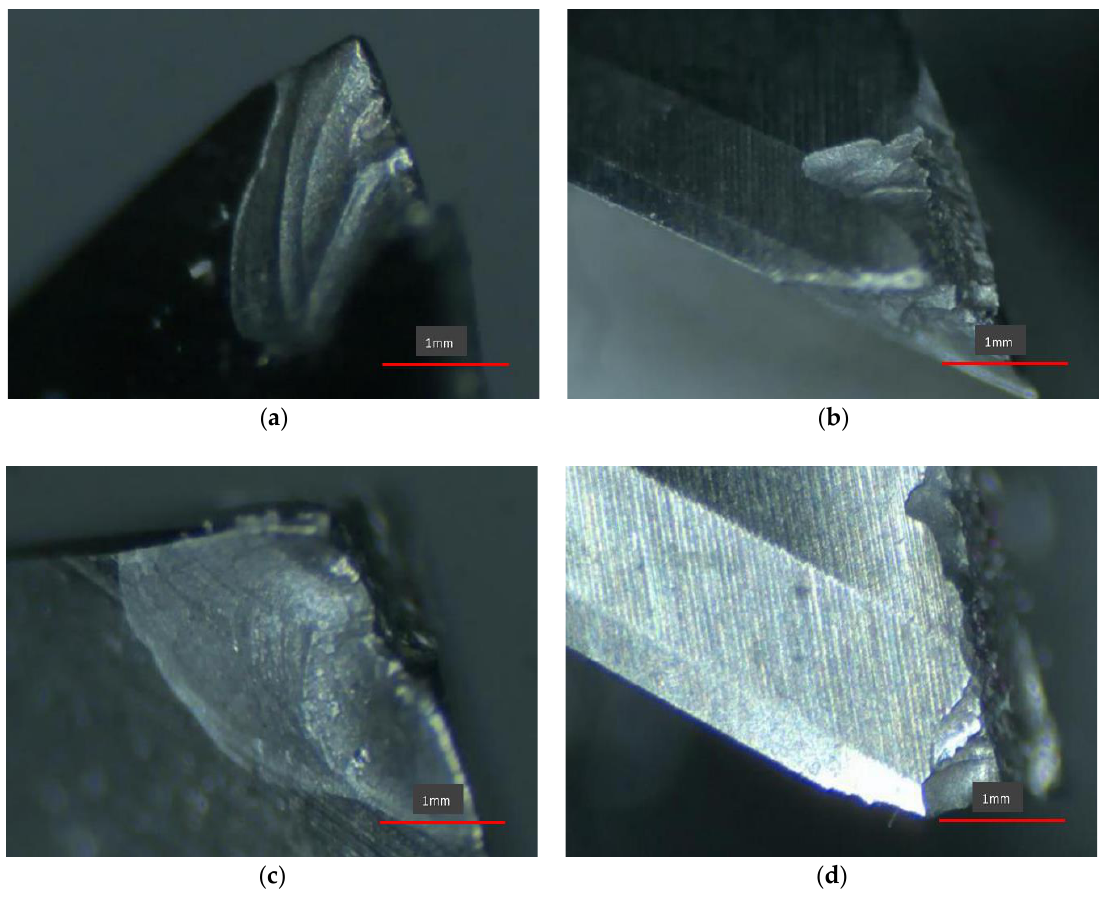
Figure 11. Wear morphology of tool. ( n = 300 r/min, a p = 0.4 mm , f z = 0.4 mm/r). ( a ) Wear morphology of flank face. ( b ) Wear morphology of rake face. ( c ) Layered flaking. ( d ) Tool chipping.